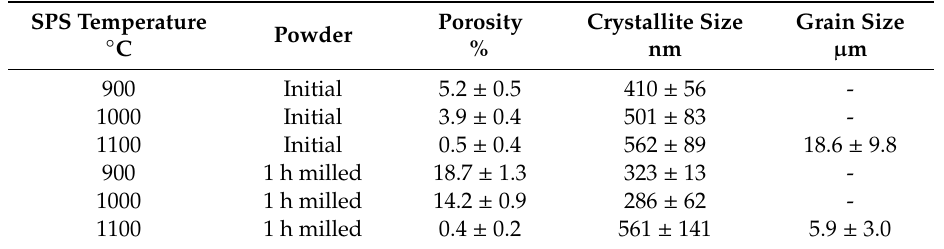
Table 3. Porosity, crystallite size, and grain size of materials sintered at 900, 1000, and 1100 °C from Fe28Al powder in the initial state and after 1 h of milling. The crystallite size determined by Scherrer calculator. The grain size obtained from EBSD data.